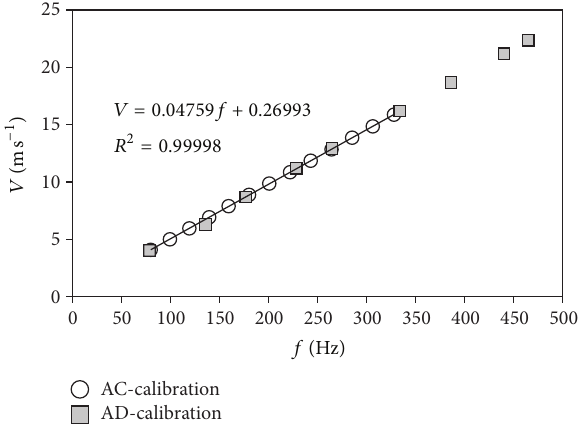
Figure 10: Results from two calibrations performed at the S4 anemometer calibration wind tunnel of the IDR/UPM Institute, on thesamecupanemometer(ThiesClima4.3350)followingtwodiffer- ent procedures, AC and AD. AC calibrations follow strictly MEAS- NET procedure (wind speeds ranging from 4 ms −1 to 16m s −1 , and 13 measurement points are taken), whereas AD calibrations are carried out over a broader wind speed range (from 4ms −1 to 23 m s −1 ) and less measurement points are taken (9 instead of